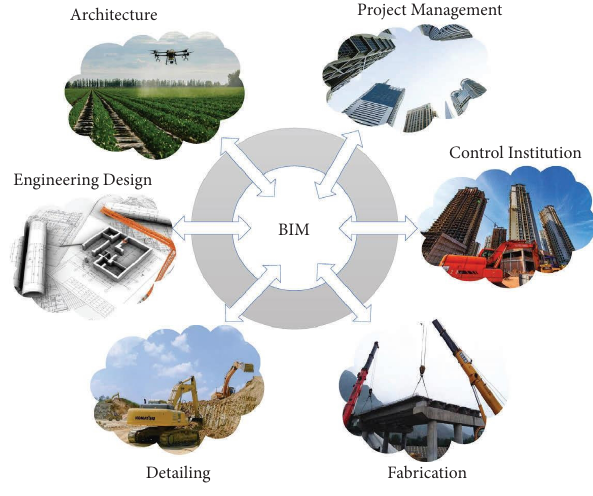
Figure 2: BIM platform.